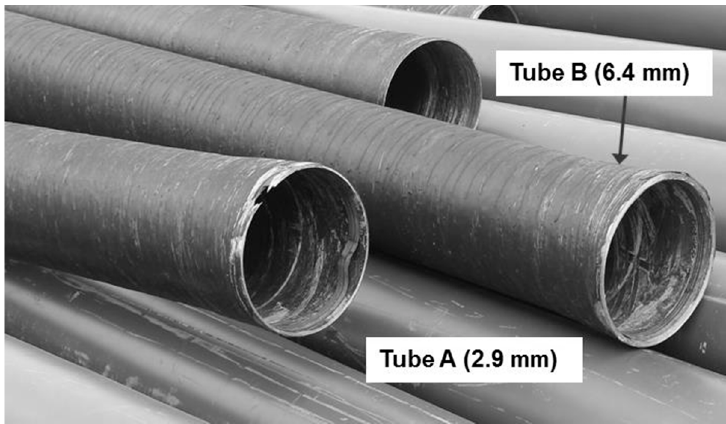
Figure 3. Filament wound glass fiber-reinforced polymer (GFRP) tubes. J. Compos. Sci. 2018 , 2 , x